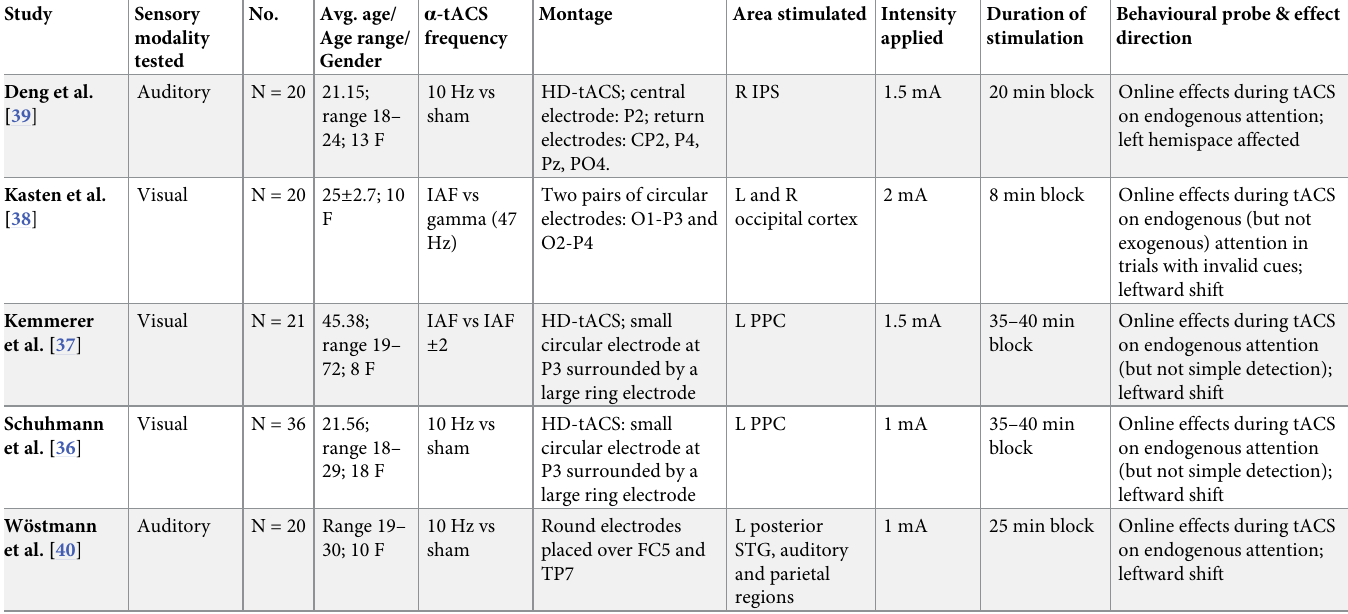
Table 1. Summary of studies using alpha tACS to modulate spatial